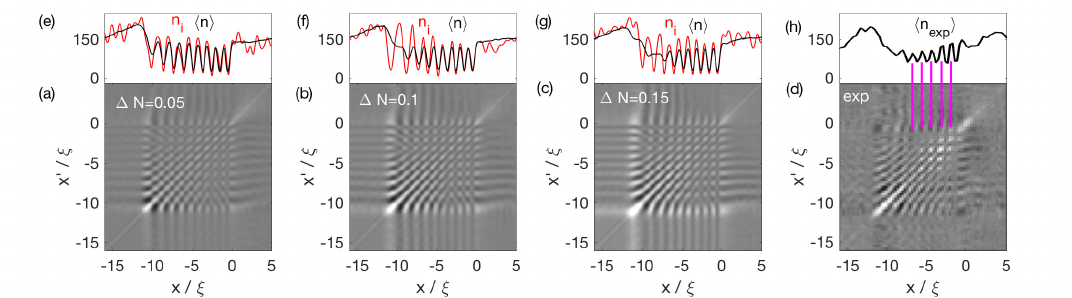
Figure 5: The density-density correlations at t = 120 ms by both number and quan- tum fluctuations. For panels (a-c), the number of condensate atoms fluctuates about ∆ N / ¯ N = 0.05,0.1,0.15, respectively. Panel (d): experimental density-density correlation taken from [ 3 ] . Top panels (e-g) are the profiles of the averaged density 〈 n ( x ) 〉 (black) and ( x ) (red). Panel (h) is the ensemble that of one realization in the corresponding ensemble , n i 〉 , taken from [ 3 ] . average of experimental density, 〈 n exp